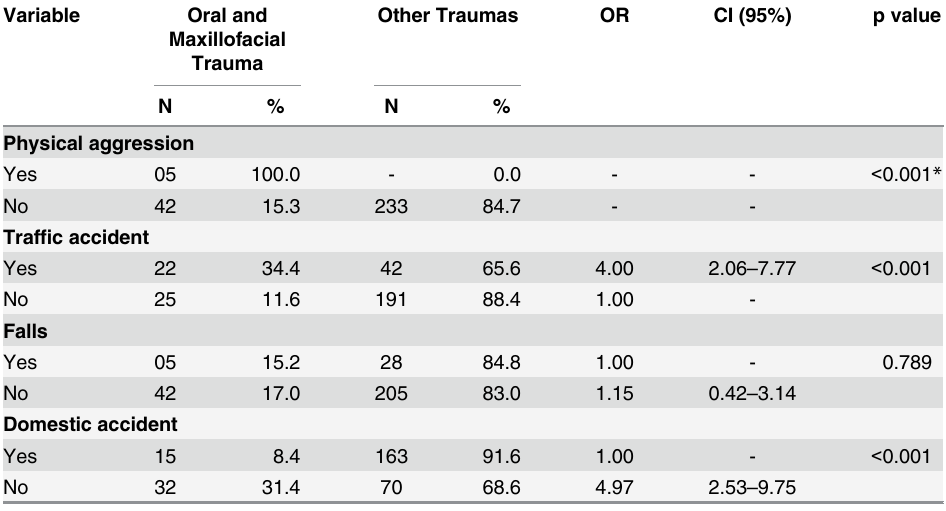
Table 2. Etiologies of oral and maxillofacial trauma (n = 47) and other types of trauma (n = 233). Forta- leza-Ceará, 2014.